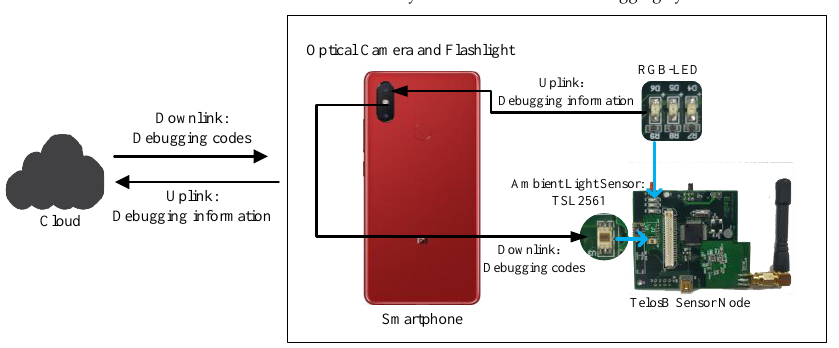
Figure 1. System overview.